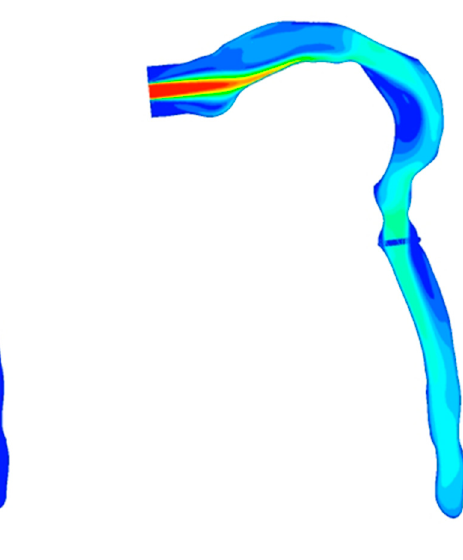
Figure 6. Total deposition fraction % at constant flow.